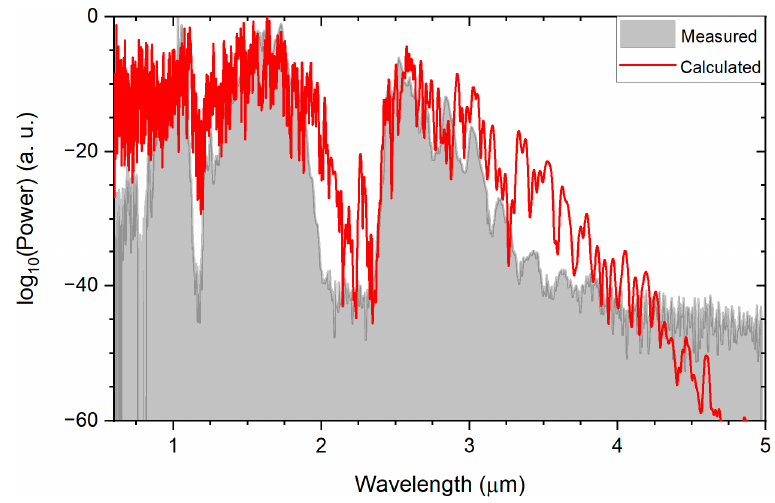
Figure 5. The measured (grey filled) and numerically simulated (red) SC spectra for the case of 1 ps, 50 µ J pump pulses coupled into the 2.9 m long HCF that was filled by D 2 at a pressure of 30 atm.